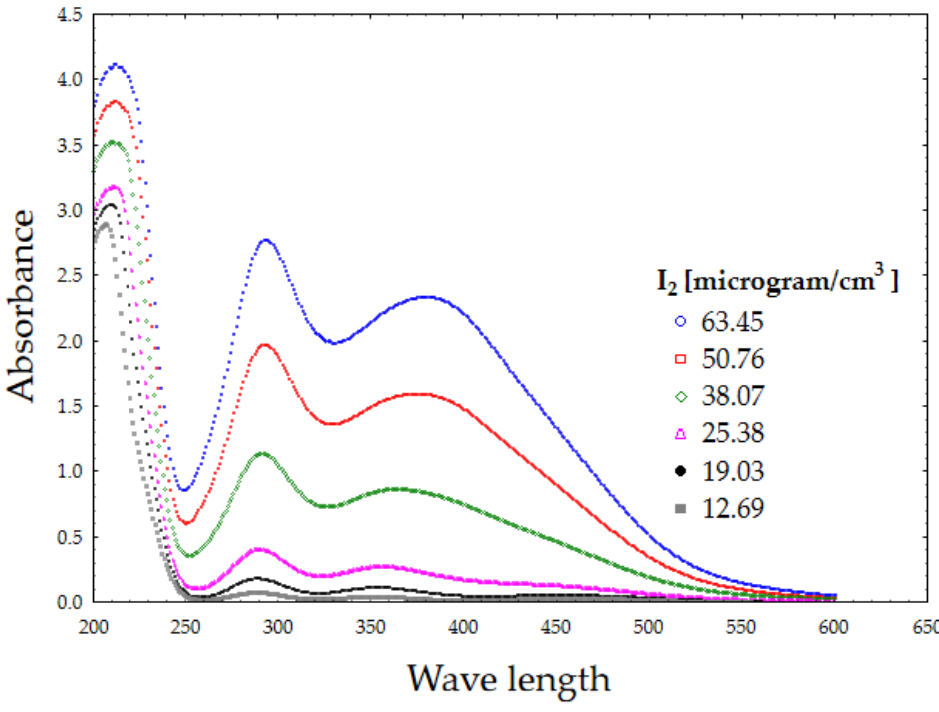
Figure 1. UV-VIS spectra of povidone-iodine (PVP-I) standard solutions.